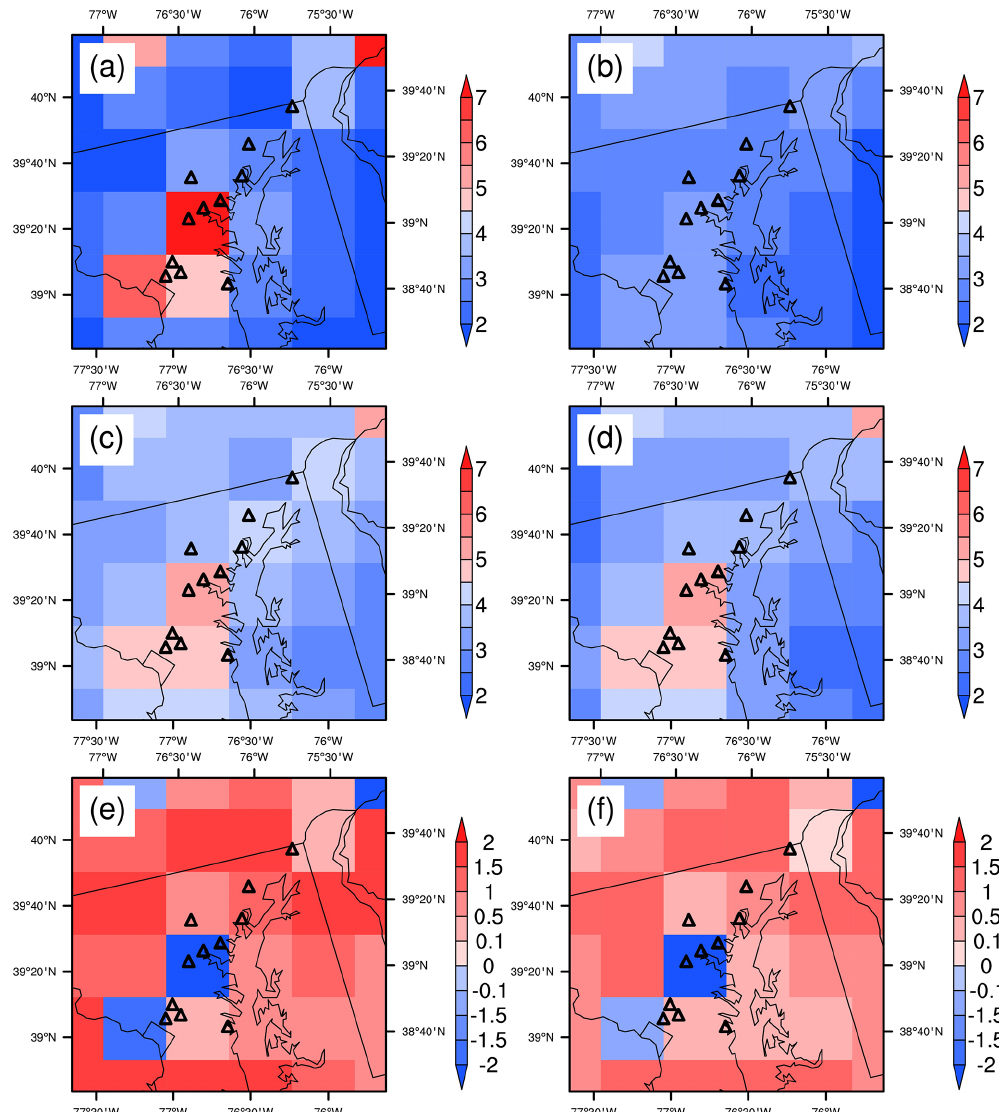
Figure 15. Distributions of weekday NO 2 TVCDs around the DISCOVER-AQ 2011 region for 13:30LT in July 2011: (a) the 36km REAM simulation results, (b) the NASA OMI product (OMNO2), (c) the KNMI OMI product, (d) the retrieved OMI NO 2 TVCDs by using the KNMI DOMINO algorithm with corresponding 36km REAM vertical profiles, (e) the distribution of the NO 2 TVCD differences ( c minus a ) between KNMI OMI and 36km REAM, and (f) the difference ( d minus a ) between retrieved OMI NO 2 TVCDs and the 36km REAM results. The NO 2 TVCD unit is 10 15 moleculescm − 2